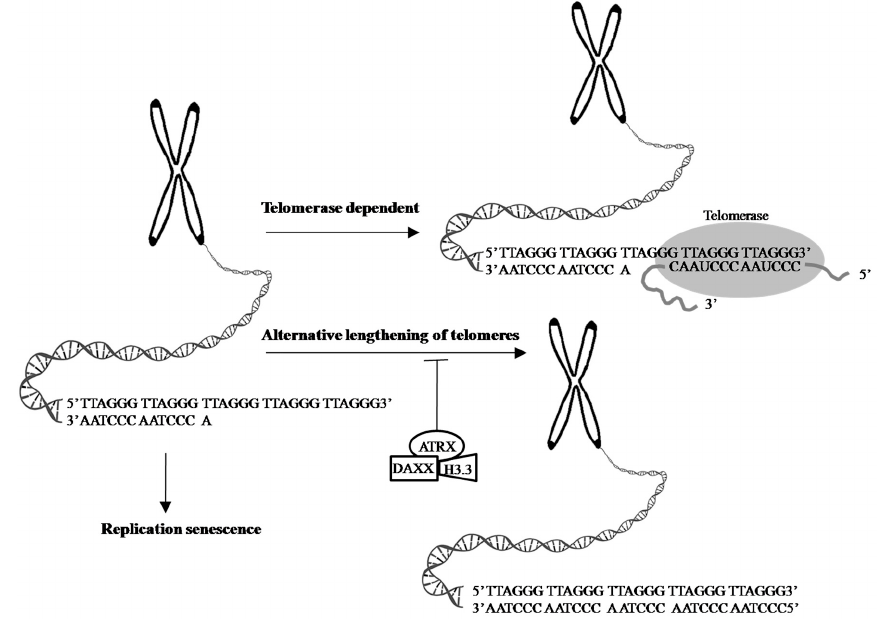
Figure 3. Telomeres are cap-like features at the ends of chromosomes that help protect them when